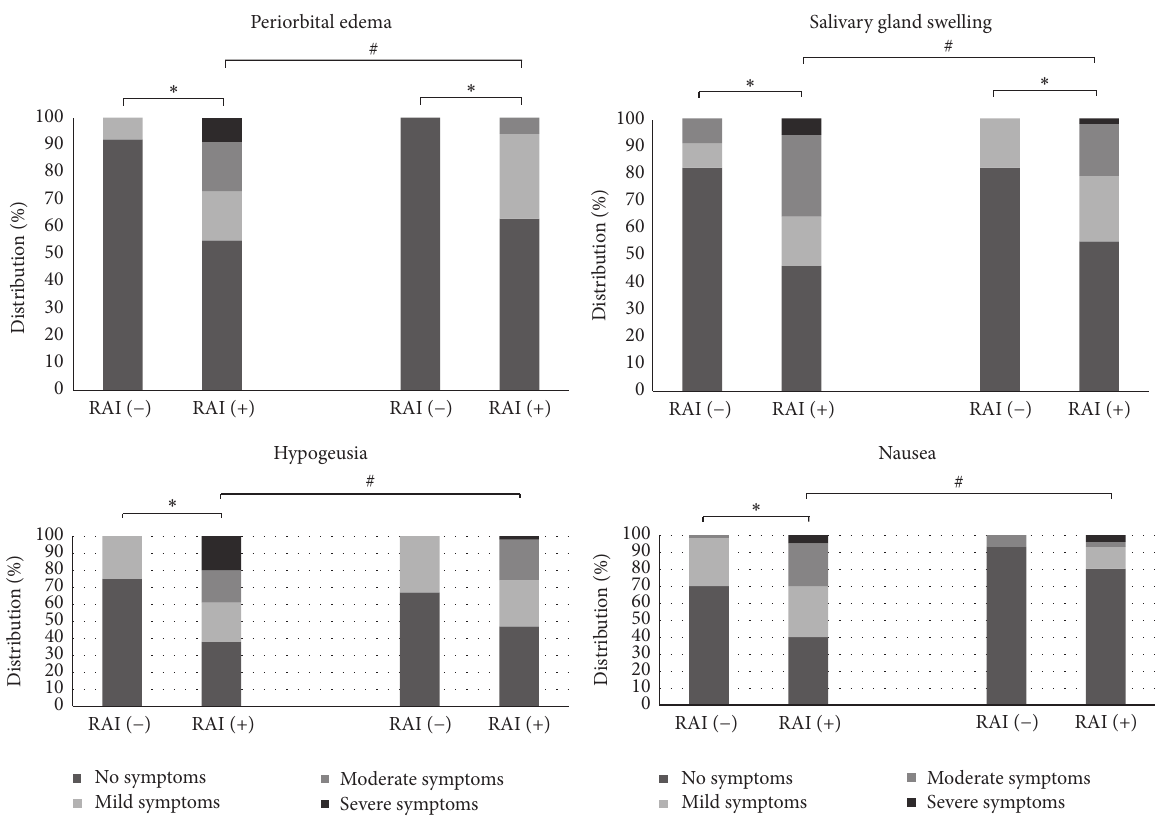
Figure 2: Distribution of intensity of early and late RAI related symptoms in patients with DTC treated with or without RAI. ∗ Statistically significant difference in intensity of symptoms among patients who did and those who did not receive RAI. # Statistically significant difference in intensity of symptoms among patients who received RAI between the first and the second survey.